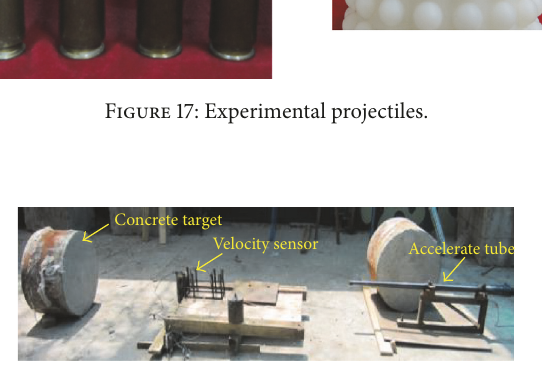
Figure 18: Experimental set-up for